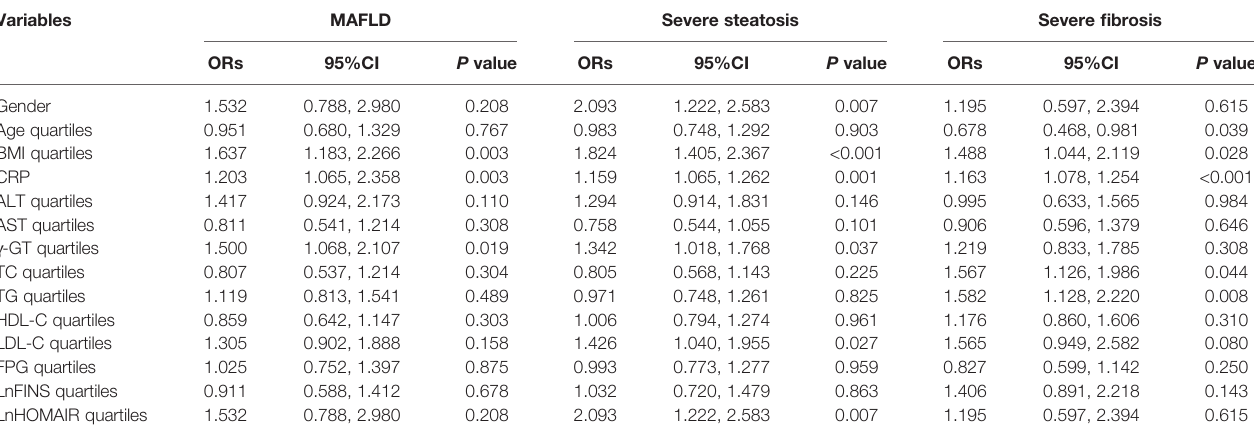
TABLE 2 | Odds ratios (ORs) of multiple variables for MAFLD, severe steatosis, and severe fi brosis. Variables MAFLD